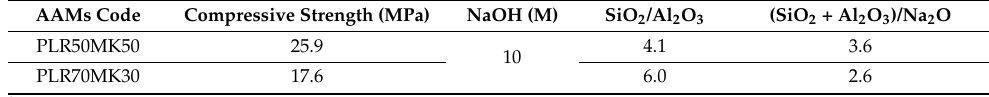
Table 5. Effect of oxide molar ratios in the reactive paste on the compressive strengths of selected AAMs 1